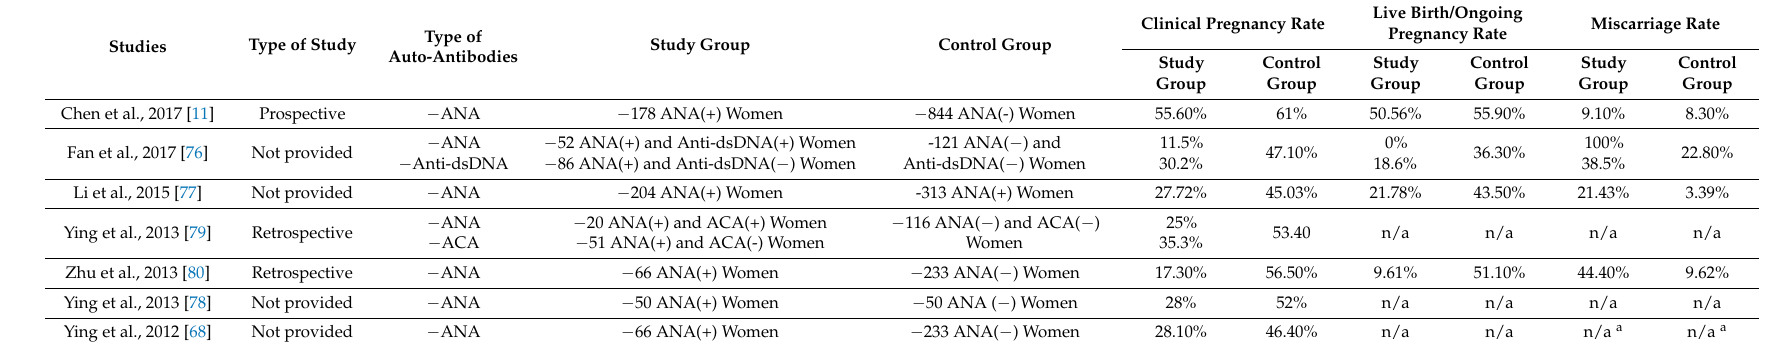
Table 3. Study characteristics regarding Anti-nuclear